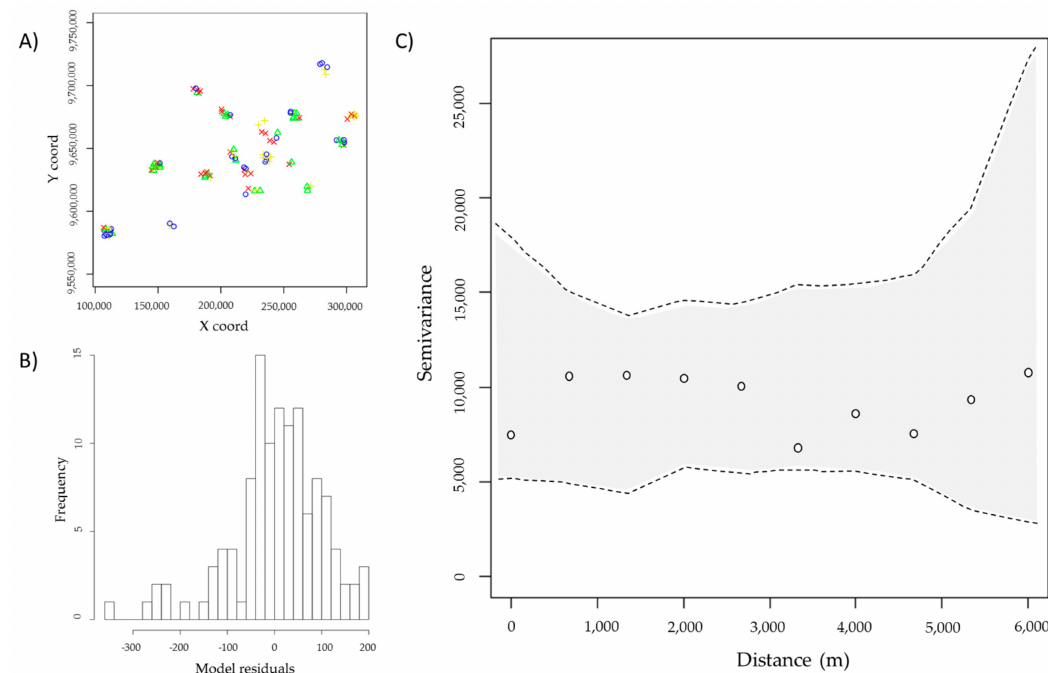
Figure 4. ( A ) Spatial distribution of the model residuals (blue, green, yellow and red colors for the respective four quartiles); ( B ) Histogram of the model residuals; ( C ) Variogram of biomass model residuals (The grey shape shows the confidence band interval expected for each distance class).